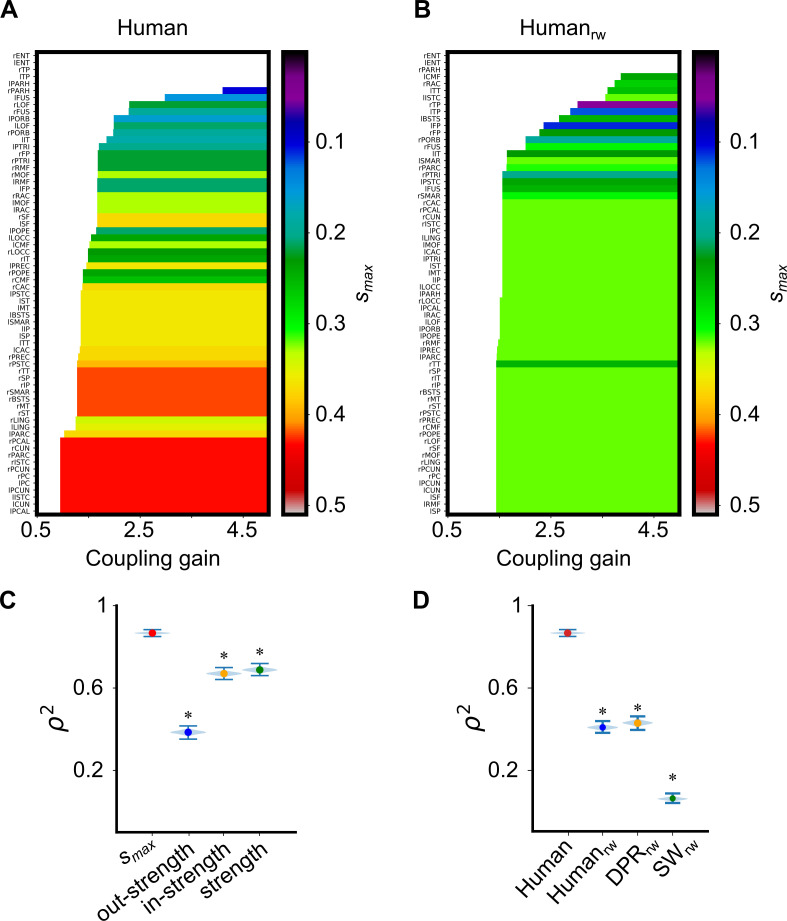
The weighted core-shell organization of Human is more related to the growing of ignited nodes than other surrogate connectomes or organization levels.(A) Cortical areas sorted in the y-axis according to the coupling gain G value at which they first ignite. The colour code shows the smax for each of the ignited cortical areas of Human. (B) The same for the Humanrw, to stress the difference in ignition recruitment through the core-shell organisation. (C) Spearman rank correlation variance (ρ2) between first ignition value G and the smax (0.867, percentile (2.5, 97.5) = (0.858, 0.874)), out-strength (0.386, percentile (2.5, 97.5) = (0.369, 0.402)), in-strength (0.670, percentile (2.5, 97.5) = (0.655, 0.684)), and strength (0.688, percentile (2.5, 97.5) = (0.672, 0.703)) of a node. The * indicates a significative difference between smax and in-, out-, and strength. (D) ρ2 between ignition value G and the smax for Human, Humanrw (0.474, percentile (2.5, 97.5) = (0.459, 0.490)), DPRrw (0.495, percentile (2.5, 97.5) = (0.477, 0.512)), and SWrw (0.100, percentile (2.5, 97.5) = (0.088, 0.112)). Human shows a higher explained variation by the core-shell organization than the wSCs. The * indicates a significant difference between the ρ2 of Human and wSCs. The significance of ρ2 was evaluated using 10.000 replicas from bootstrap resampling (violin plots).